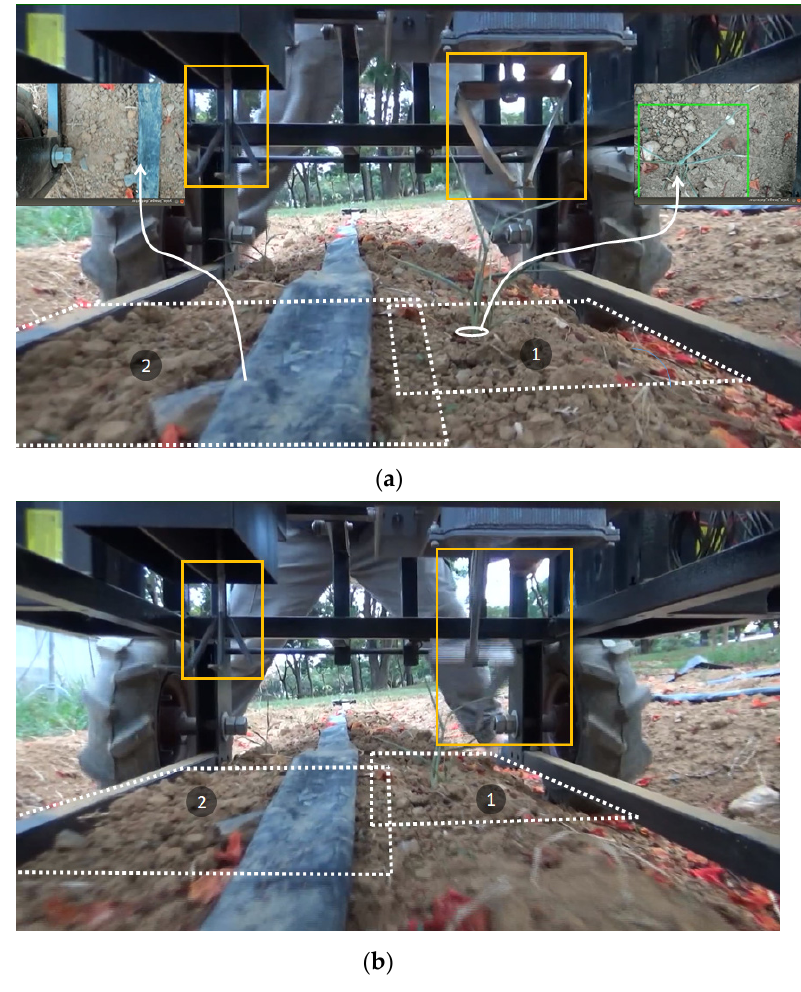
Figure 10. The operation of the weeder. The orange lines indicate the claw rake (left) and the inverted triangle (right) weeding tools. The white dotted line indicates the area of view taken by the two cameras on the left and right weeders. ( a ) The weed object is framed (the detection result of area (cid:182) (upper right corner)) and no weed is detected (the detection result of area (cid:183) (upper left corner)); ( b ) the weeding tool on the right is activated, and the left weeding cutter is maintained at the origin of the mechanism. Table 4. Performance evaluation results of the weeding